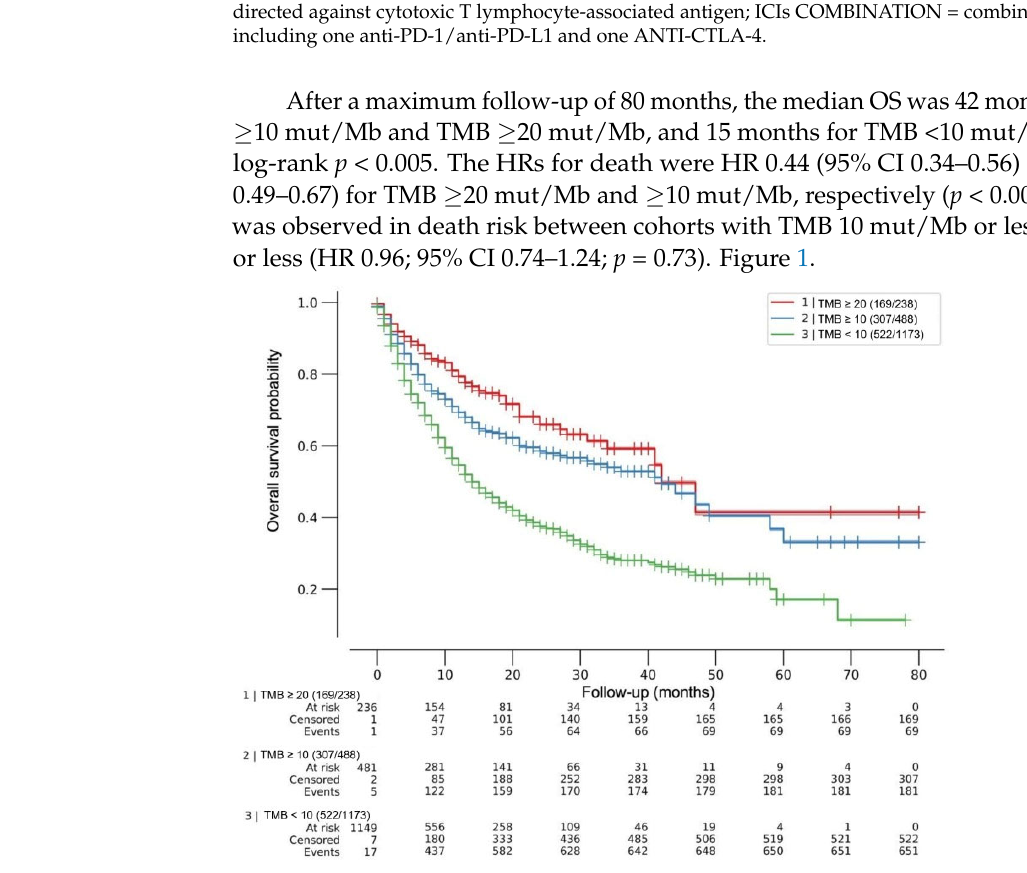
monoclonal antibody directed against programmed cell death ligand 1; ANTI-CTLA-4 = monoclonal antibody directed against cytotoxic T lymphocyte-associated antigen; ICIs COMBINATION = combined treatment regimen including one anti-PD-1/anti-PD-L1 and one ANTI-CTLA-4.